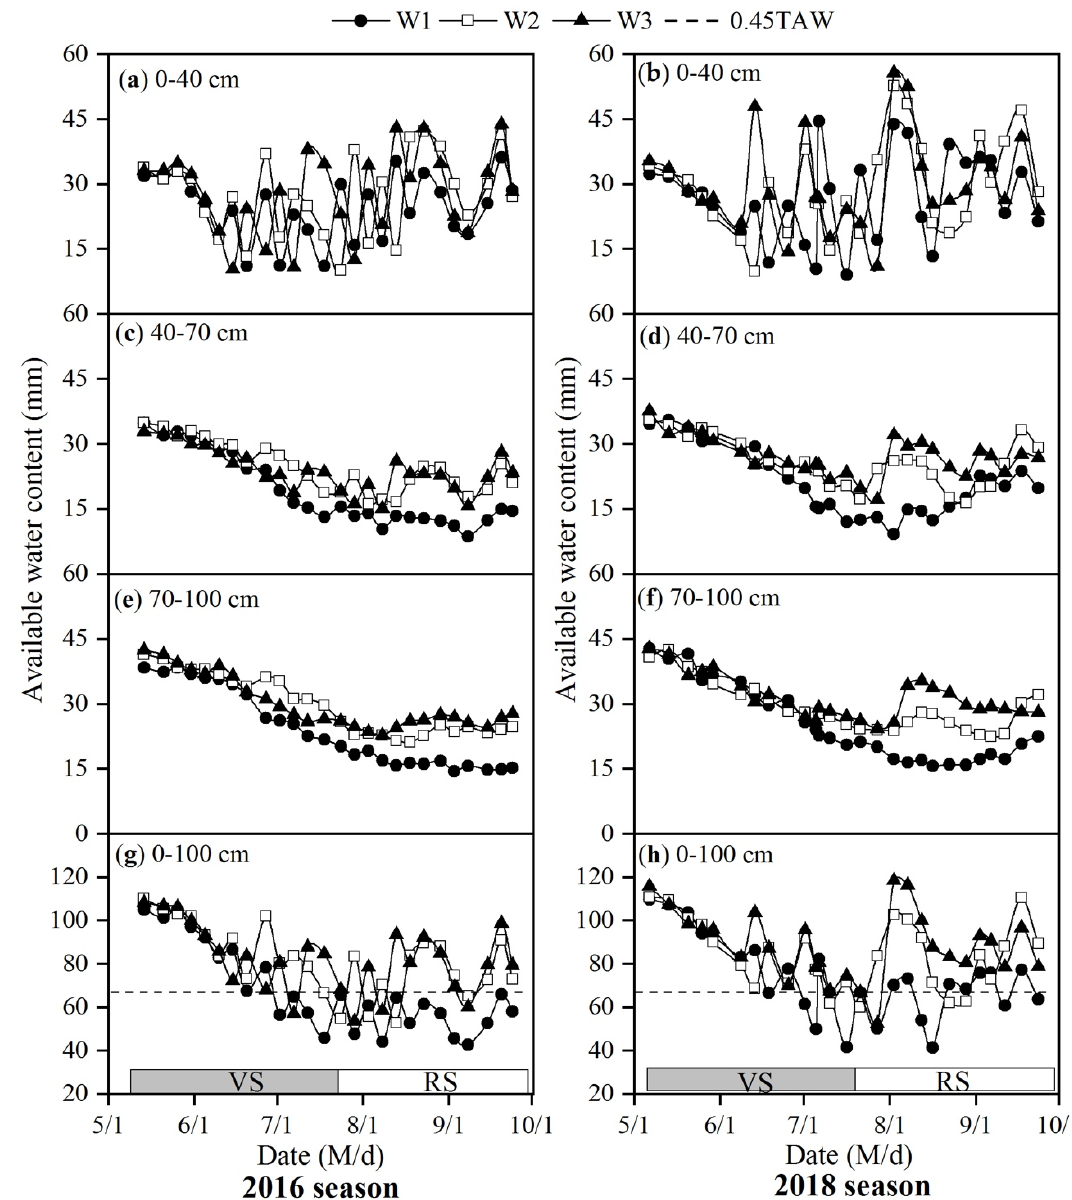
Figure 2. Available water content at soil layers of 0–40 cm ( a , b ), 40–70 cm ( c , d ), 70–100 cm ( e , f ) and 0–100 cm ( g , h ) for W1, W2 and W3 in 2016 (left panel) and 2018 (right panel). W1, W2 and W3 are the treatments with different D h (designed wetting depth). D h values in W1, W2 and W3 are 0–40 cm,